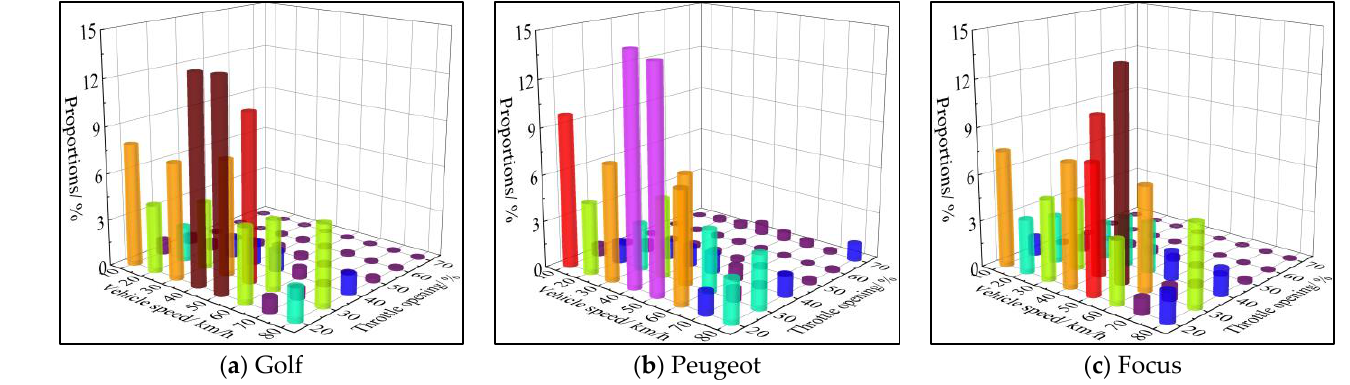
Figure 4. Operation distribution vs. vehicle speed and throttle opening.